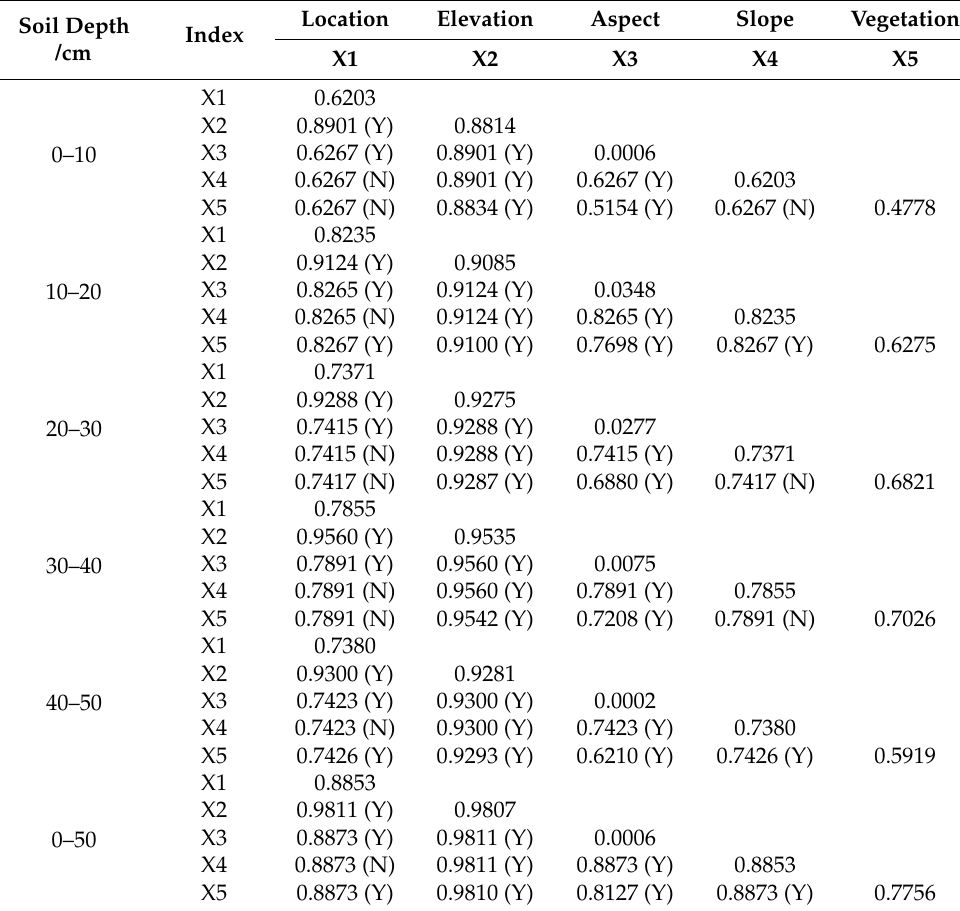
Table 6. Evaluation factor interaction